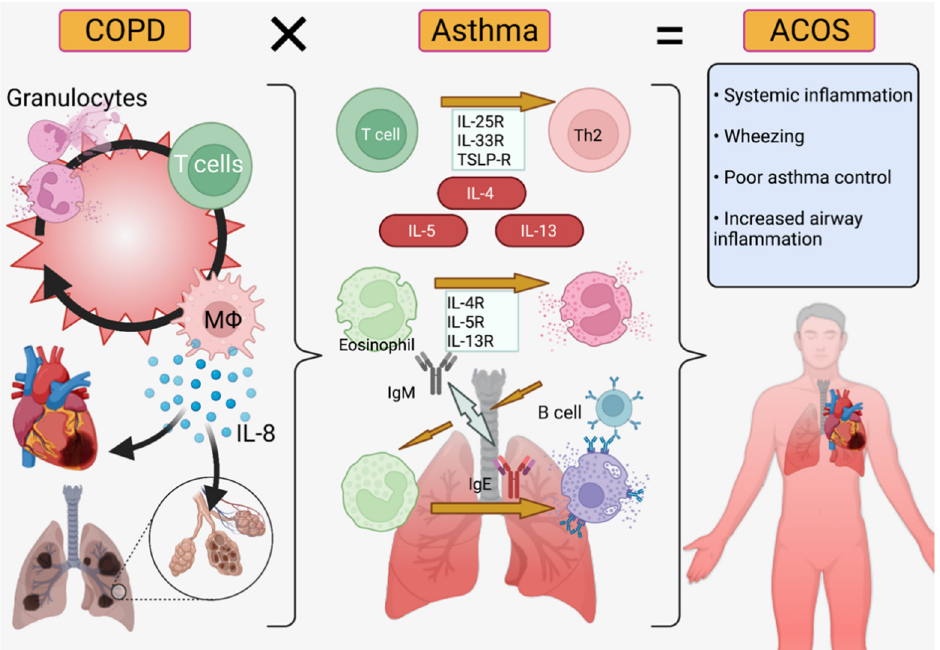
Figure 6. Asthma-COPD Overlap Syndrome (ACOS). Chronic obstructive pulmonary disorder ( left ) is primarily IL-8/neutrophil mediated while asthma ( center ) is IL-4/5/13 and T-cell mediated ACOS ( right ) features symptoms from both diseases and requires increased inflammation control [16,17,176]. Created in BioRender.com.